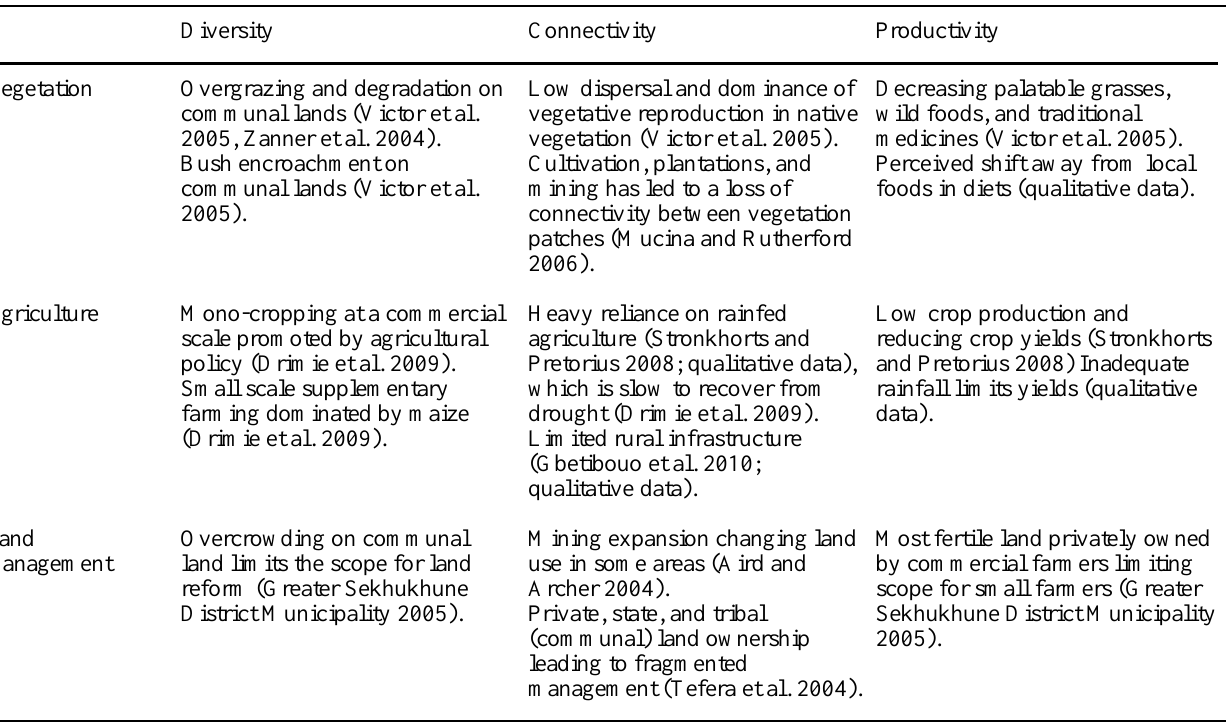
Table 4. Summary of evidence from the literature and qualitative data showing the key drivers of vulnerability of the agroecosystem to changing weather patterns. Diversity Connectivity Productivity